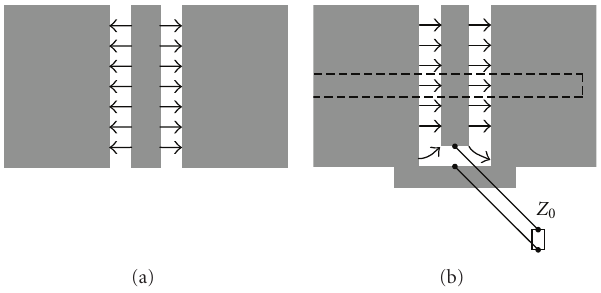
Figure 3: Electromagnetic field distribution, (a) CPW feeding port and (b) microstrip feeding port.